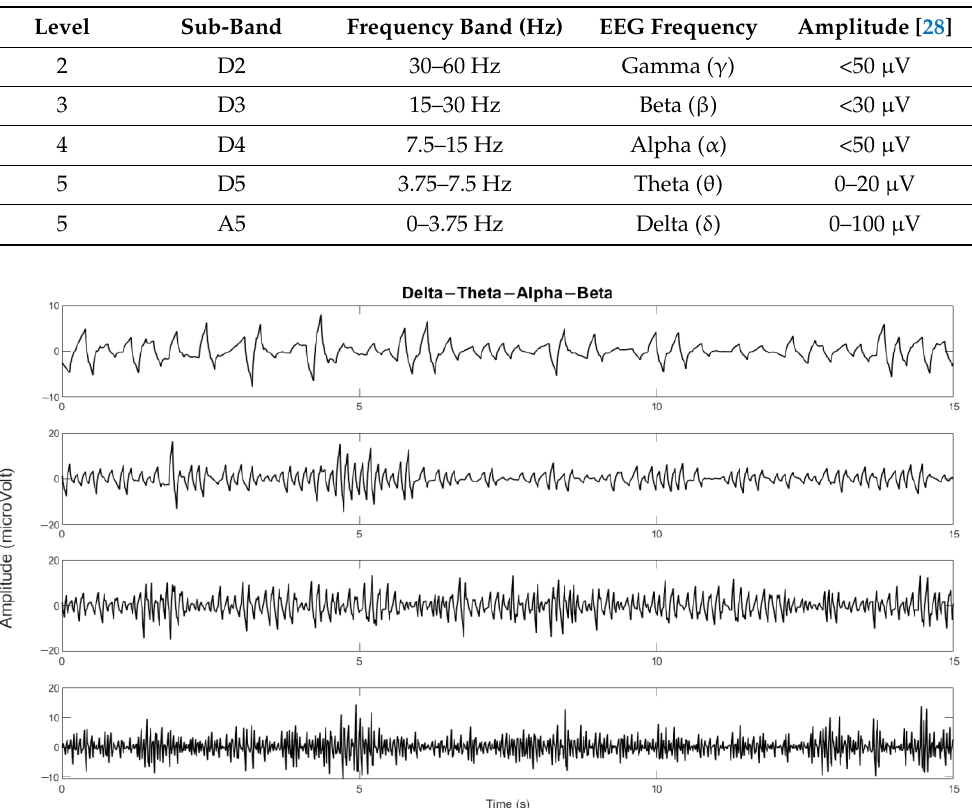
Table 2. Wavelet sub-band and corresponding EEG frequency.